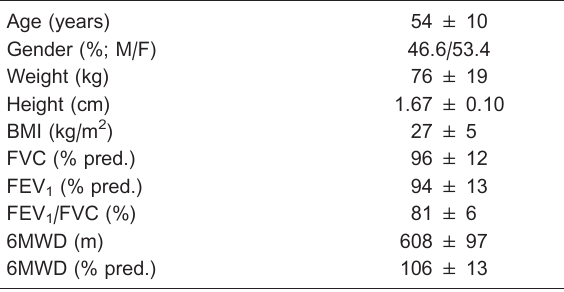
Table 1. General characteristics of the study sample